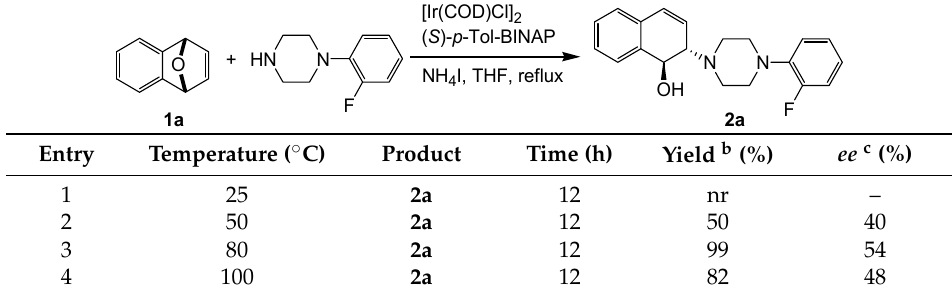
Table 3. Effects of the temperature on the ring-opening a .